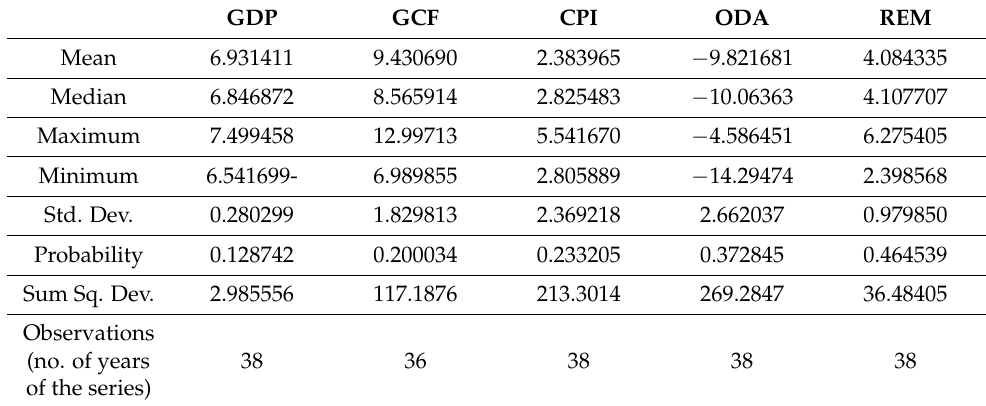
Table 1. Summary Statistics of logarithms of CPI, GCF, GDP, ODA and REM per capita from 1980 to